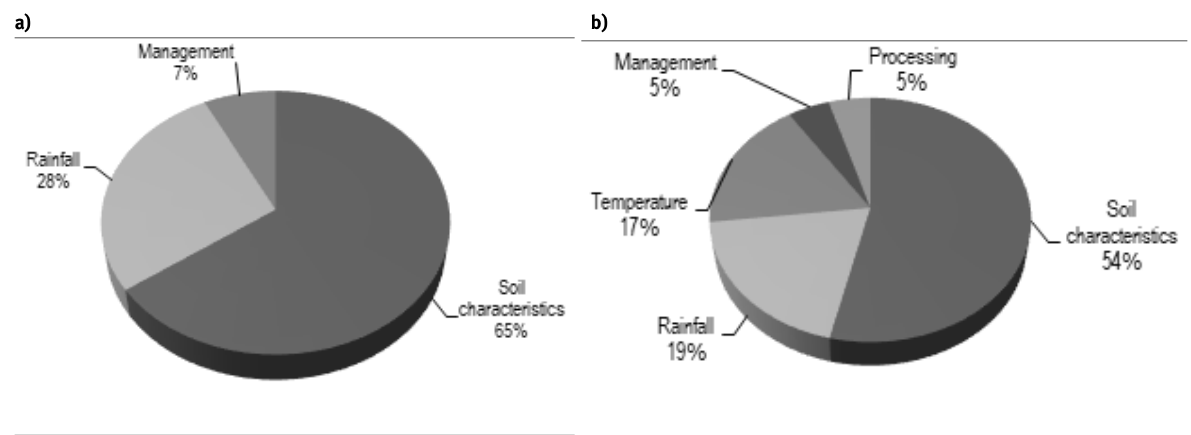
Figure 3: Producer perceptions on the sources of uniqueness of (a) coffee and (b) tea as potential GI